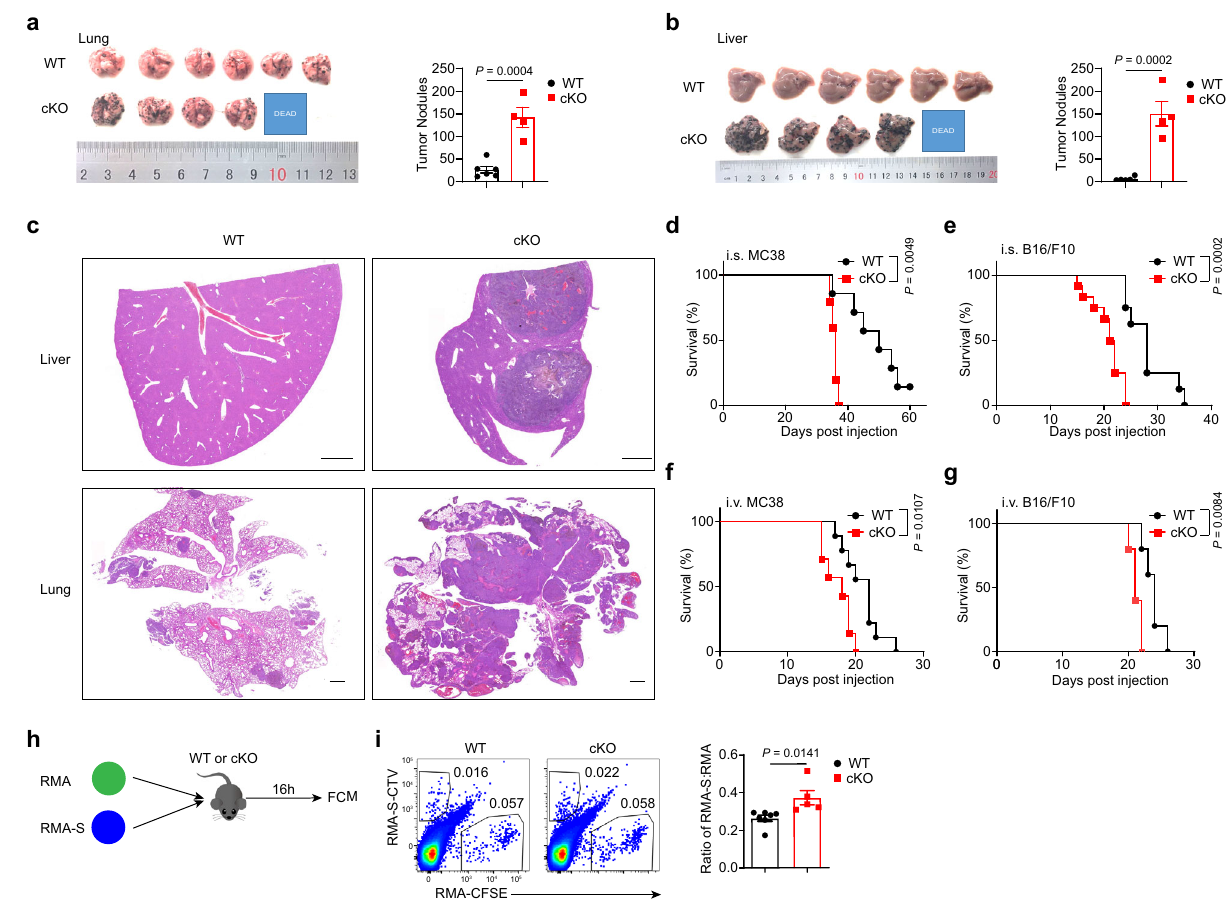
Fig. 2 Mettl3 deletion in NK cells fails to control tumor development. a Imaging of lungs (left) and tumor nodules in lungs (right) from WT ( n = 6) or cKO ( n = 4) mice 16 days after intravenous injection of 5 × 10 5 B16/F10 cells. b Imaging of livers (left), and tumor nodules in livers (right) from WT ( n = 6) or cKO ( n = 4) mice 16 days after intravenous injection of 5 × 10 5 B16/F10 cells. c Representative hematoxylin and eosin (H&E) staining images of the liver (top) and lung samples (bottom) from WT mice or cKO mice after intravenous injection of 2 × 10 5 B16/F10 cells. Scale bars represent 1 mm. d Survival of WT mice ( n = 7) and cKO mice ( n = 5) after intrasplenic injection of 2 × 10 5 MC38 cells. e Survival of WT mice ( n = 8) and cKO mice ( n = 12) after intrasplenic injection of 2 × 10 5 B16/F10 cells. f Survival of WT mice ( n = 9) and cKO mice ( n = 7) after intravenous injection of 5 × 10 5 MC38 cells. g Survival of WT mice ( n = 5) and cKO mice ( n = 5) after intravenous injection of 2.5 × 10 5 B16/F10 cells. h WT mice or cKO mice were co-transferred with 5 × 10 6 CFSE-labeled RMA cells and 1.5 × 10 7 CTV labeled RMA-S cells, and splenocytes were harvested 16 h later. i Representative plots (left) showing expression of CTV and CFSE in the spleen, and a statistical graph showing the ratio of RMA-S cells: RMA cells ( n = 7) or cKO ( n = 5) mice in ( i ). Each symbol represents an individual mouse ( a , b , d , e , f , g , i ). Data are the mean ± SEM (unpaired two-tailed t test ( a , b , i ) or two-tailed log-rank (Mantel – Cox) test ( d – g )). Source data are provided as a Source Data fi le. Data represent at least two independent experiments ( a – d , g - i ) or are pooled from two independent experiments ( e , f